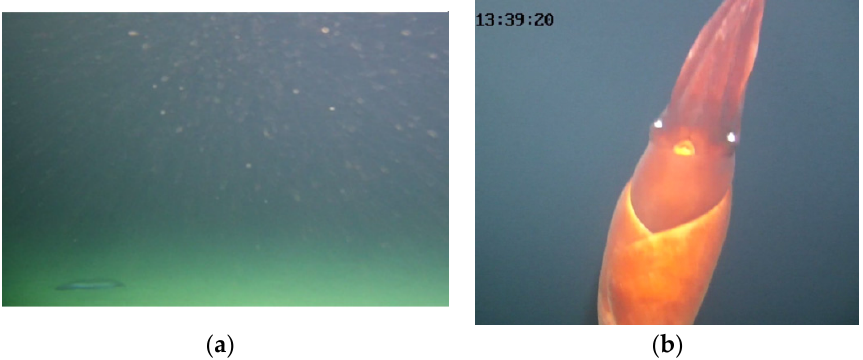
Figure 24. ( a ) Near-bottom cruising at 1000 m level; ( b ) deep-sea octopus found in 600 m water depth.